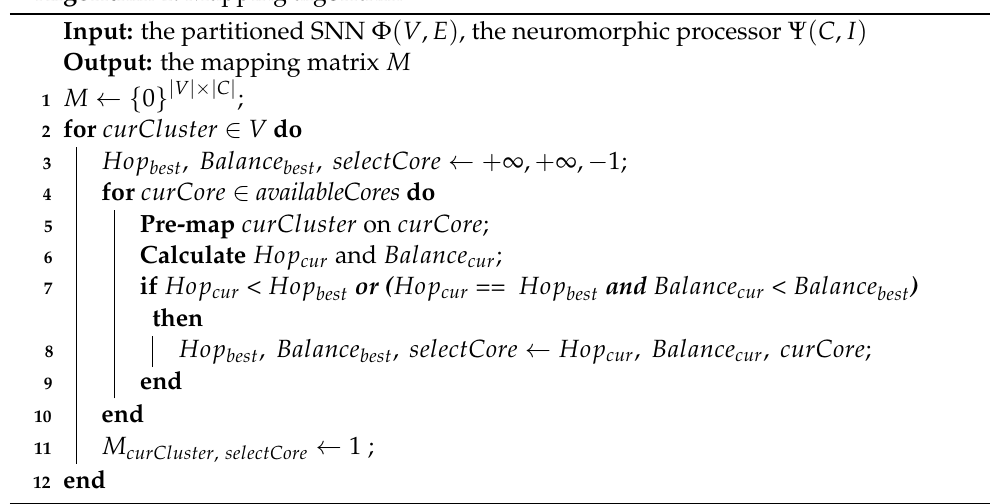
Algorithm 1: Mapping